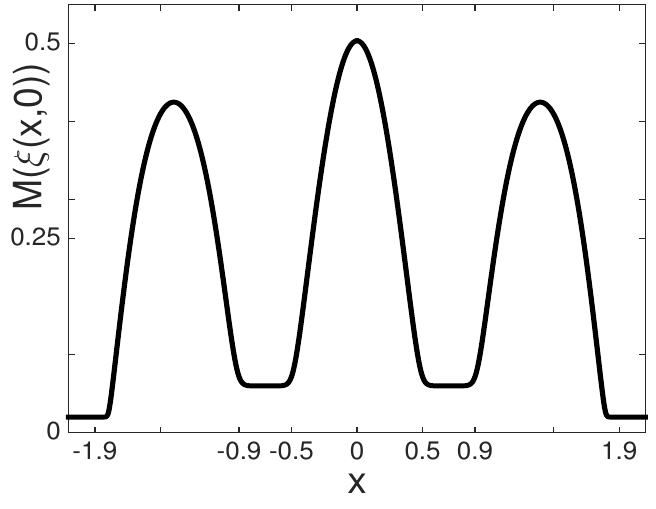
Figure 3. The metric coefficient M ( ξ ( x ,0 ))